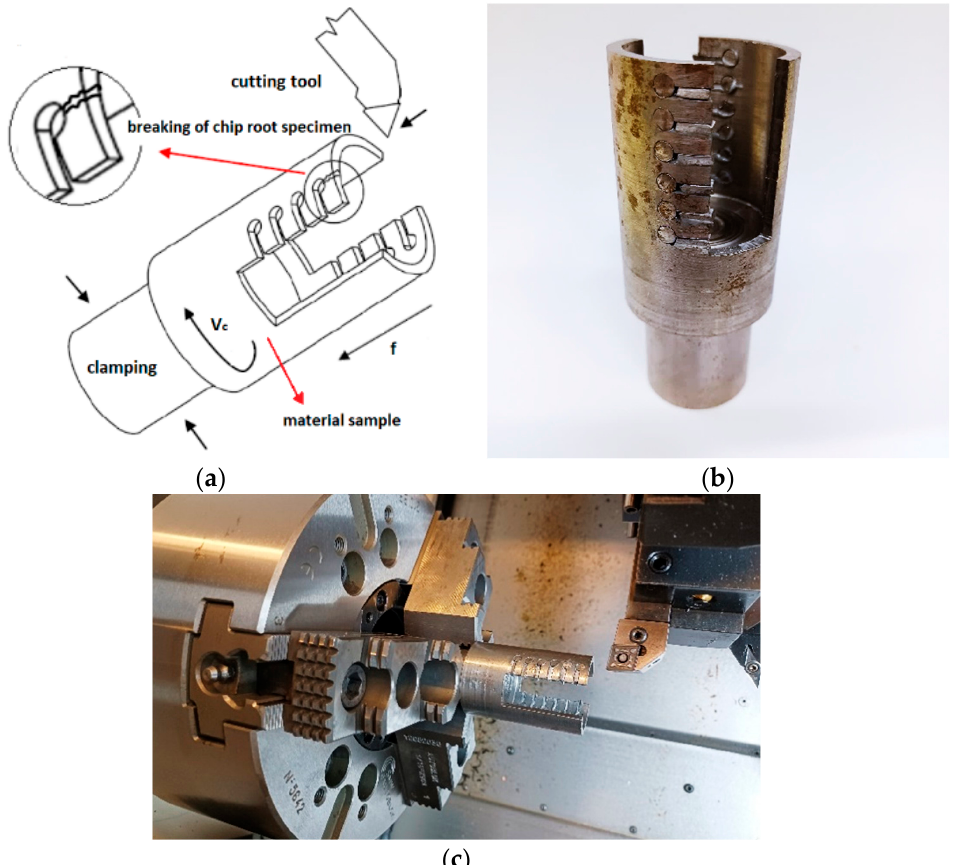
Figure 1. Material samples for obtaining the cutting zone. ( a ) Schematic illustration of the cutting zone, obtained from [54], ( b ) the Cutting zone samples, and ( c ) the Process of obtaining the cutting zone.